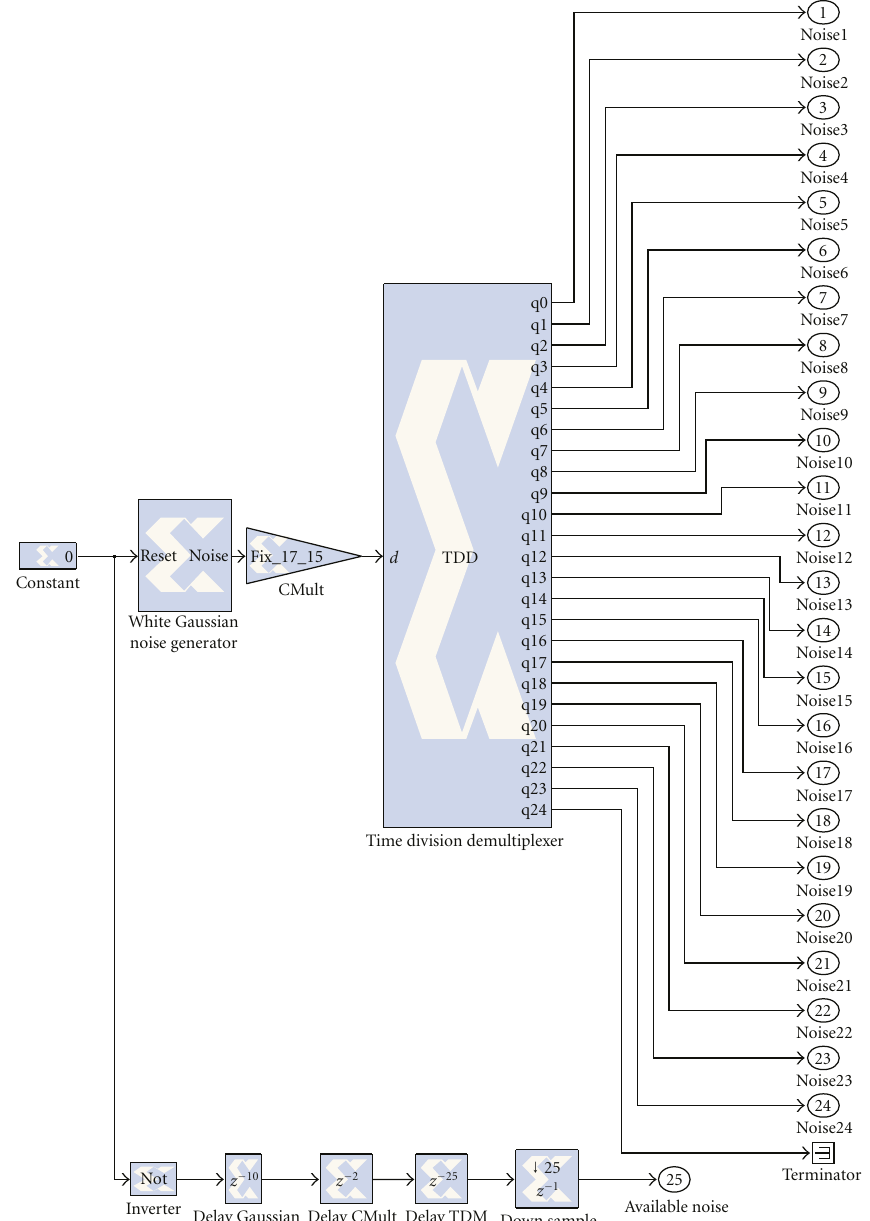
Figure 3: Resource-e ffi cient 24-output Gaussian noise